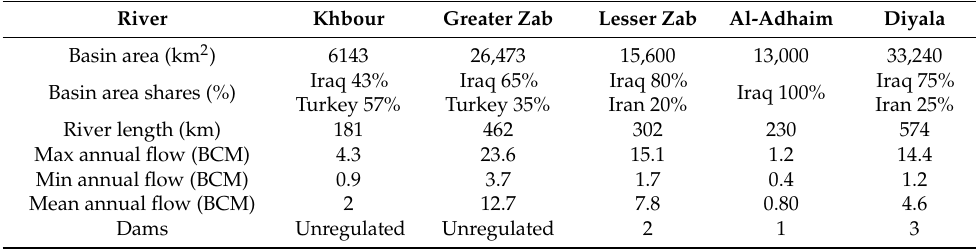
Figure 1. The location map of the study area. Table 1. Description of the basins of the five tributaries in northeast Iraq.